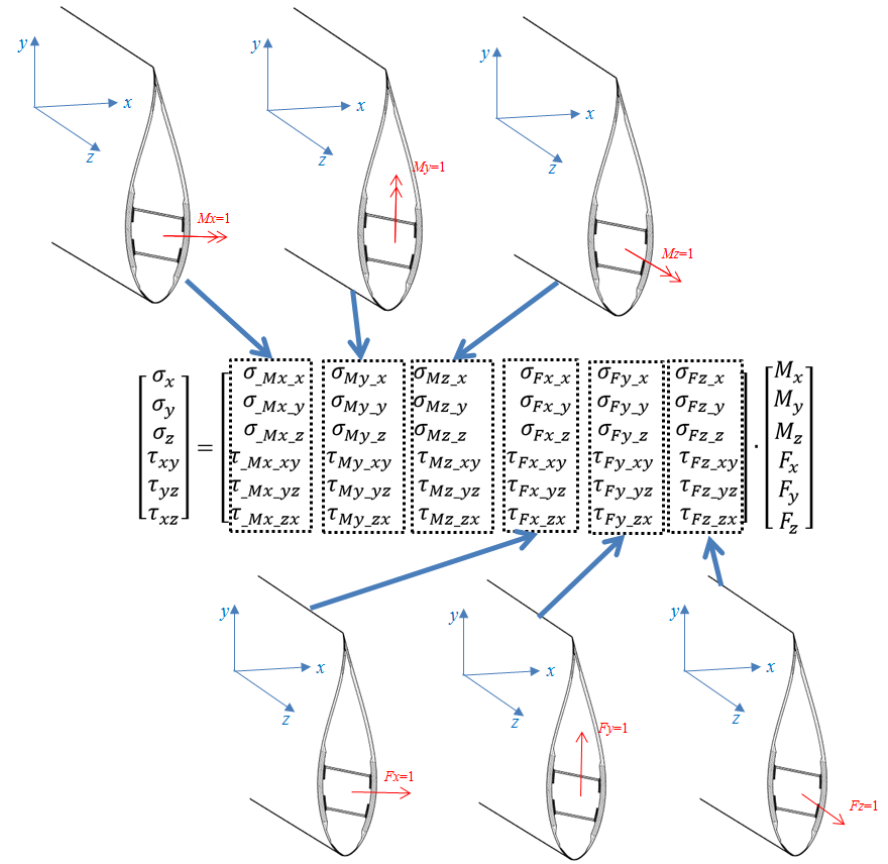
Figure 10. Schematic diagram to obtain the transformation matrix.